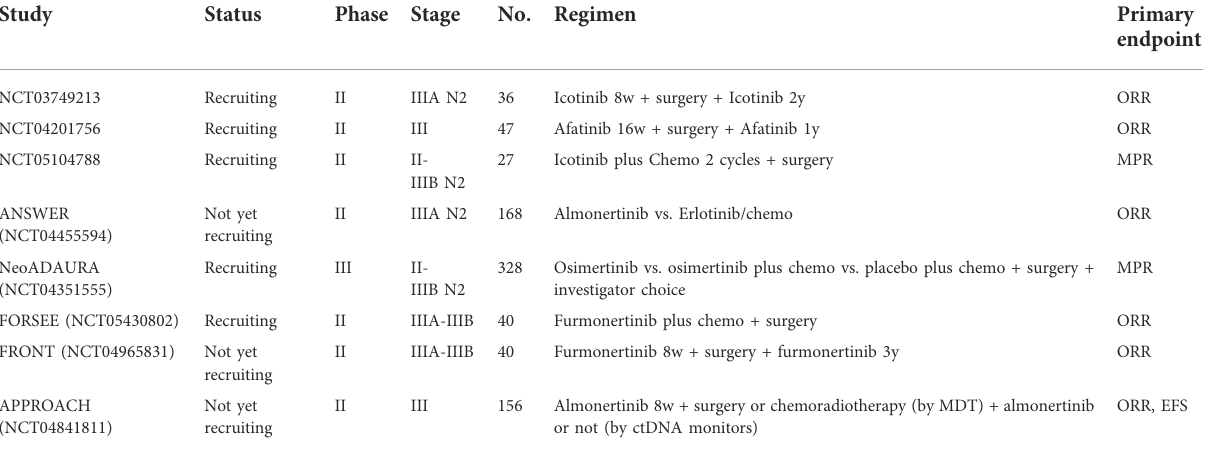
TABLE 2 Ongoing clinical trials investigating neoadjuvant EGFR-TKIs in EGFR-mutated